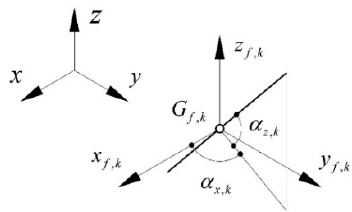
Figure 2. Geometric parameters defining the position of the generic fiber within the concrete beam.